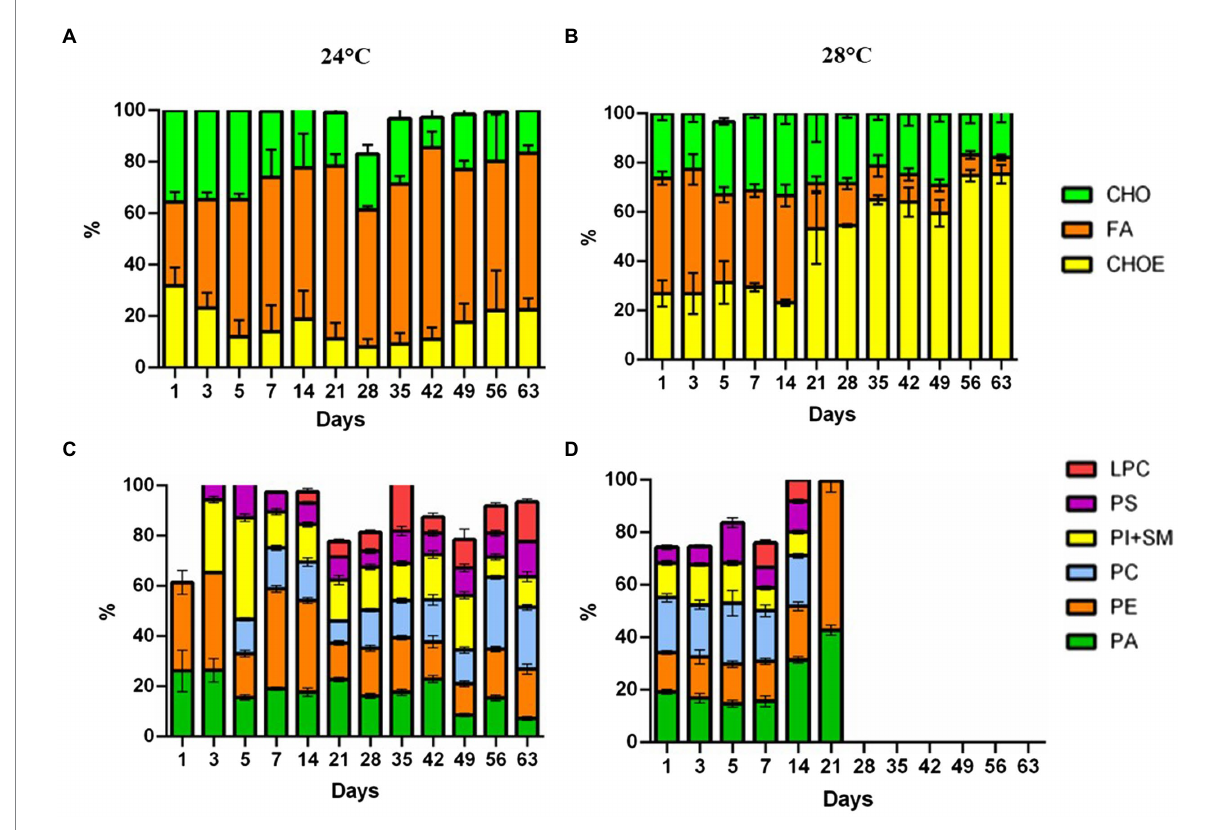
FIGURE 3 Lipidome analysis of Cladocopium cultured at 24 ° C and 28 ° C. Lipid composition in CCMR093 cells is expressed as the integral band values of HPTLC analysis. Panels (A,B) represent phospholipids and Panels (C,D) neutral lipids. LPC, lysophosphatidylcholine; SM, sphingomyelin; PI, phosphatidylinositol; PC, phosphatidylcholine; PA, phosphatidic acid; PS, phosphatidylserine and PE, phosphatidylethanolamine. MG, Monoacylglycerol; CHO, Cholesterol; FA, Free Fatty Acids; TG, Triacylglycerol; CHOE, Cholesteryl-esters; Unidentified lipids were not represented in the